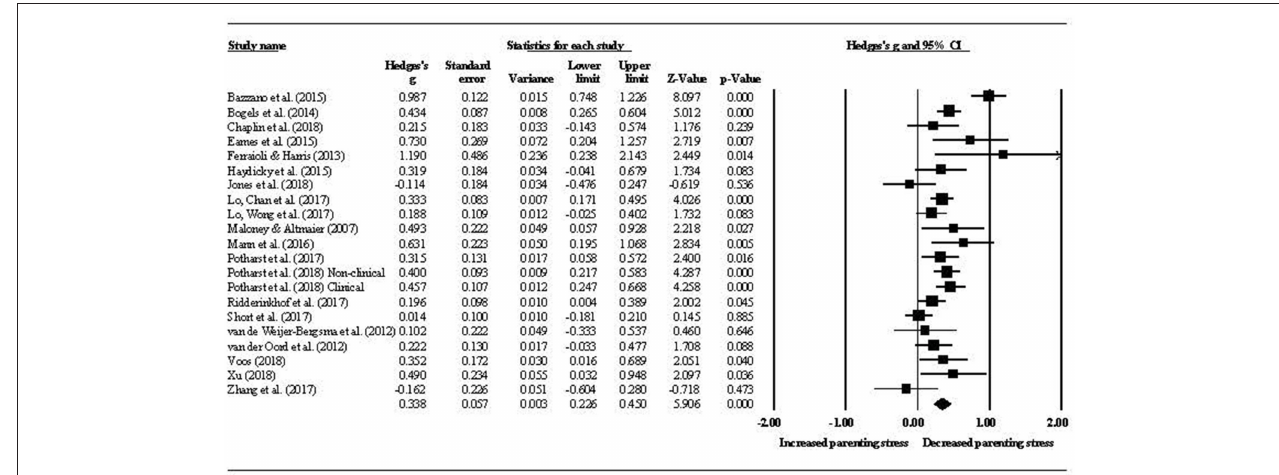
FIGURE 2 | Pre- to post-intervention change in parenting